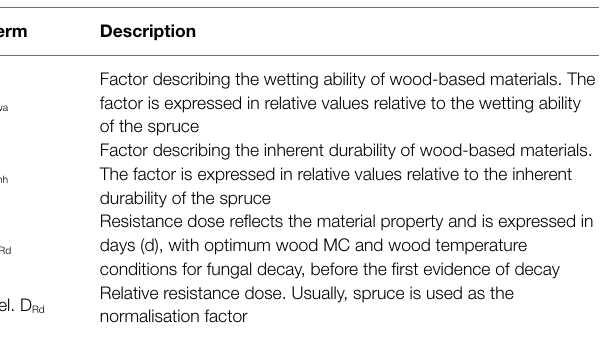
TABLE 1 | Description of key terms addressed in respective